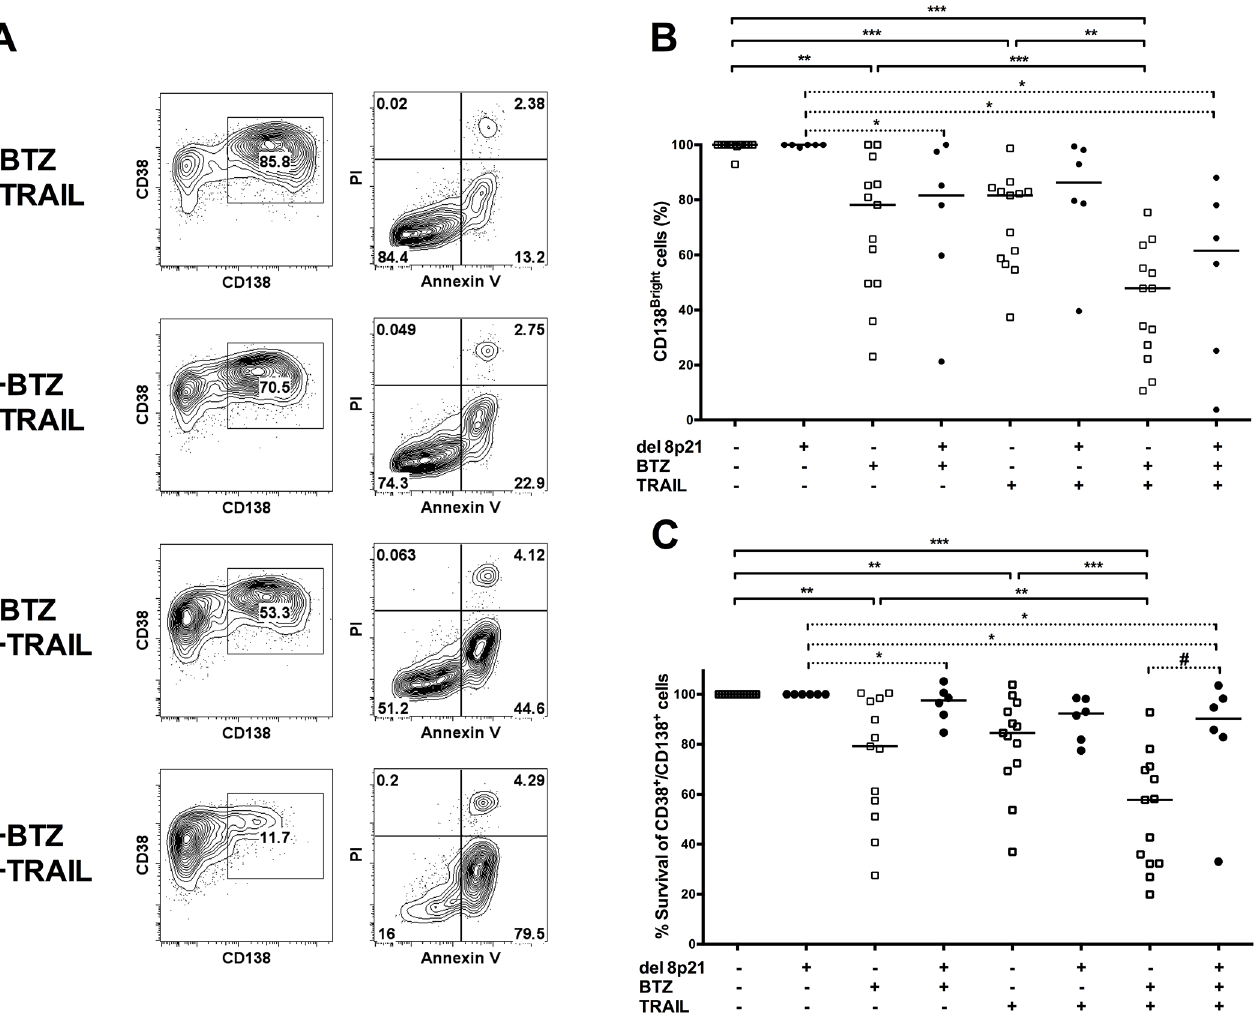
Fig 4. Patients with del(8)(p21) are less sensitive to bortezomib and TRAIL mediated apoptosis. CD138 expression levels and Annexin V/PI staining was performed to assess viable, apoptotic and dead cells. Mononuclear cells were separated by Lymphoprep from fresh bone marrow aspirates of MM patients followed by CD138 positive magnetic selection. Cells were incubated overnight with or without 10 nM bortezomib followed by incubation with or without 250 ng/ml soluble TRAIL/APO2L for 6 hours. Thereafter, cells were stained with anti-CD38, anti-CD138, anti-Annexin V antibodies and PI. (A) Representative patient data displaying relative changes in CD38 + /CD138 Bright cell population (left panel) and Annexin V/PI (right panel) upon bortezomib and/or soluble TRAIL/APO2L treatment. (B) Relative changes in the CD38 + /CD138 Bright cell population of 13 MM patients without del(8)(p21) and 6 MM patients with del(8)(p21) upon bortezomib and/or soluble TRAIL/APO2L treatment is displayed. Amount of CD38 + /CD138 Bright cells of each untreated patient MM cells is considered as 100%. (C) Relative percentage of live MM cells (Annexin V - and PI - cells) of 13 MM patients without del(8)(p21) and 6 MM patients with del(8)(p21) is displayed. Percentage of untreated live MM cells is considered as 100%. Statistical analysis of bortezomib and/or TRAIL treatment is assessed with Wilcoxon rank test in patients with or without del(8)(p21). * P < 0.05, ** P < 0.01, *** P < 0.001. Mann-Whitney test was performed to compare patients groups with and without del(8)(p21). # P < 0.05. Median values for each group are displayed in B and